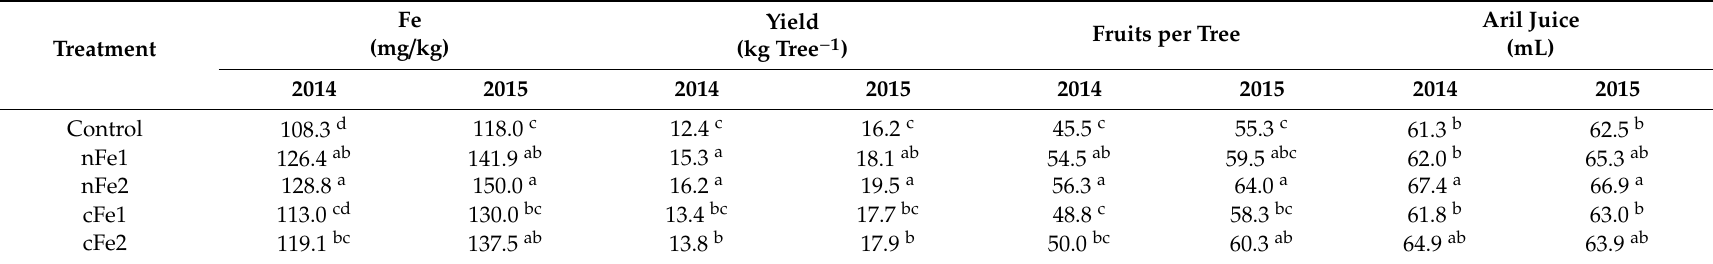
Table 1. E ff ect of foliar fertilization with FeSO 4 (nFe) and Fe(III)-EDDHA (cFe) on pomegranate leaf Fe concentrations, fruit yield, number of fruits per tree and aril juice in 2014 and 2015.